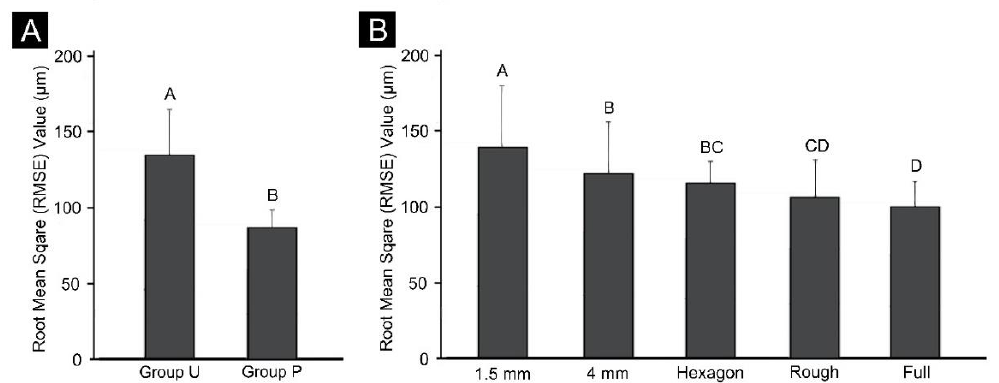
Figure 4. Results of the two-way ANOVAs of trueness ( A ) between Groups U and P, and ( B ) between the groups with different internal structures. Uppercase letters indicate significant differences. Data are the mean and SD values.